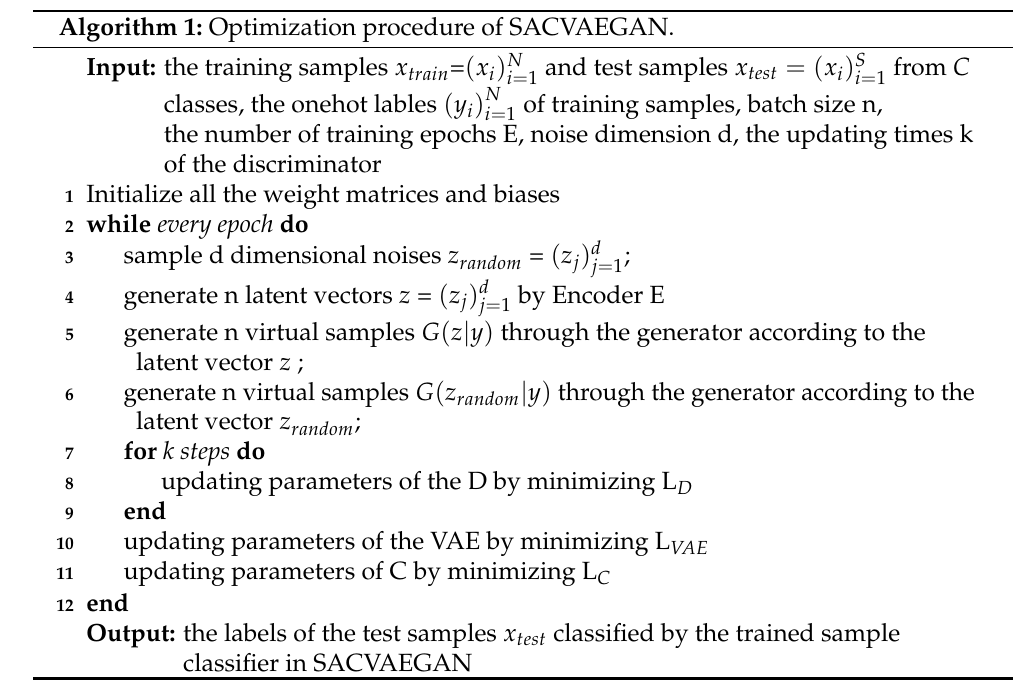
Algorithm 1: Optimization procedure of